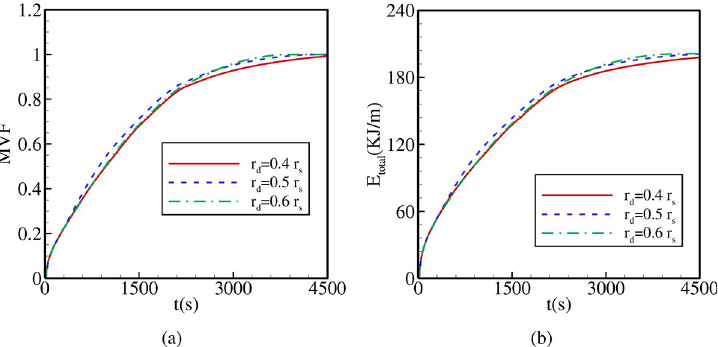
Fig 11. The effects of r = 5, and η = π